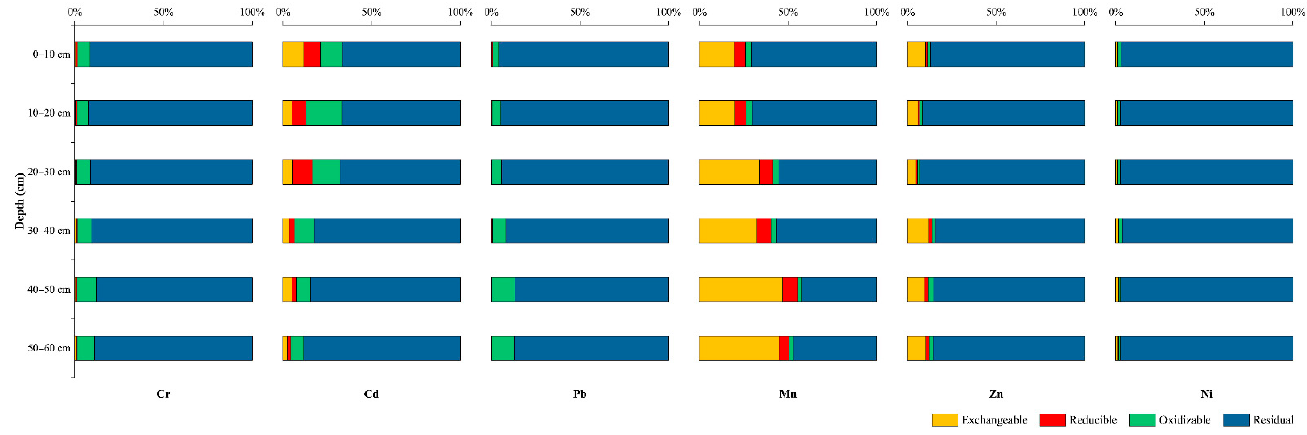
Figure 6. Percentage of each speciation for heavy metals in profile samples in HFR. For the topsoils (Figure 7), as the residual fraction of heavy metals is mainly derived from the mineral and influenced by rock weathering and soil erosion, it is extremely dif ‐ ficult for them to migrate or be transformed in the environment, and thus Cr and Pb are the least toxic heavy metals in the study area and are not affected by sewage irrigation, which is consistent with the sediment findings. The average percentage of (F1 + F2 + F3) for Zn and Ni was 11%, and the most significant increase compared to the sediment was found in the Ni component ( p < 0.01). It is possible that this change is the result of selective uptake by plants; Research on the absorption of specific heavy metals by various crops mentioned that wheat grown in sewage irrigation soil is enriched in Zn and Ni, especially Ni, which is the most likely heavy metal to be absorbed by plants, followed by Zn, Fe, Mn, and Cu, while wheat is the least effective at absorbing Mn among the numerous crops assessed [69]. Mn and Cd have the largest proportion of F1 exhibiting a particularly strong